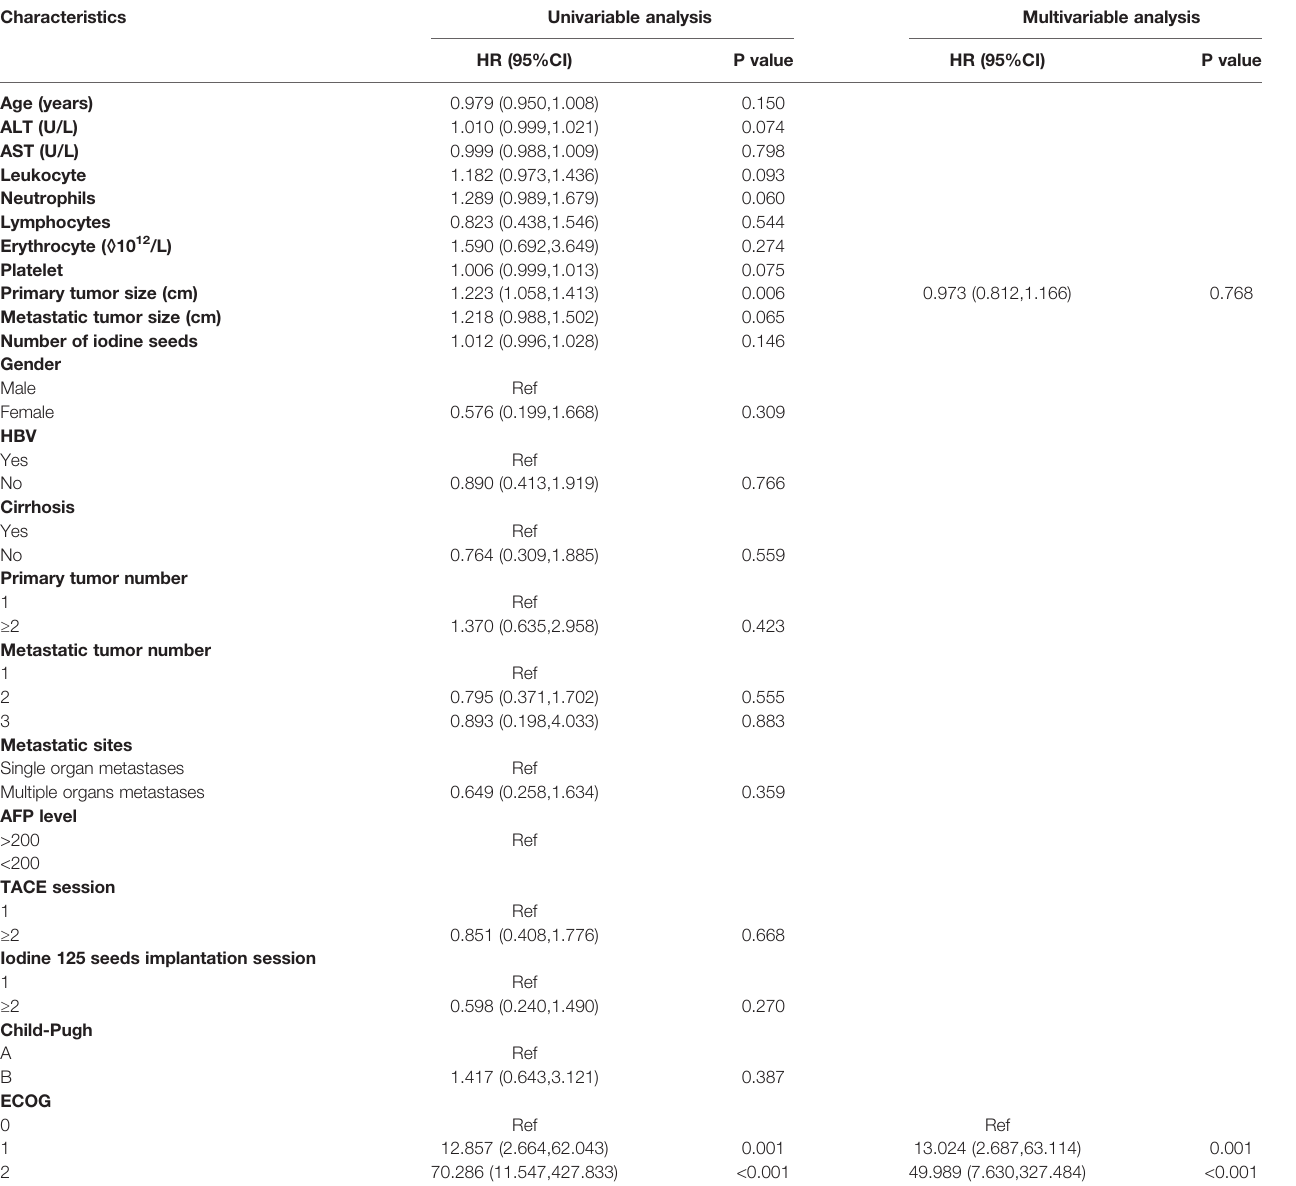
TABLE 3 | Univariable regression analysis and multivariable regression analysis for